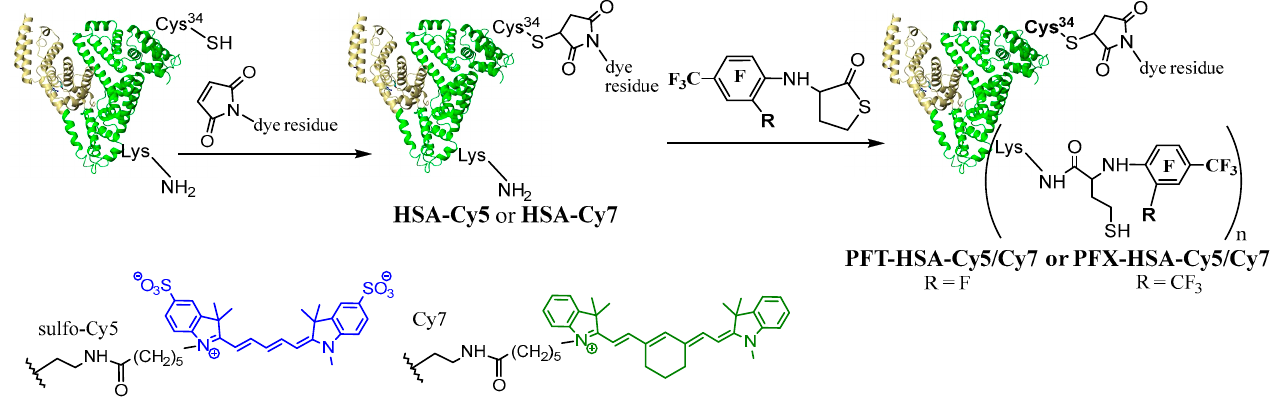
Figure 10. Synthetic route to PFT-HSA-Cy and PFX-HSA-Cy conjugates. Framework (shown sche- matically as a heart-like structure)—human serum albumin